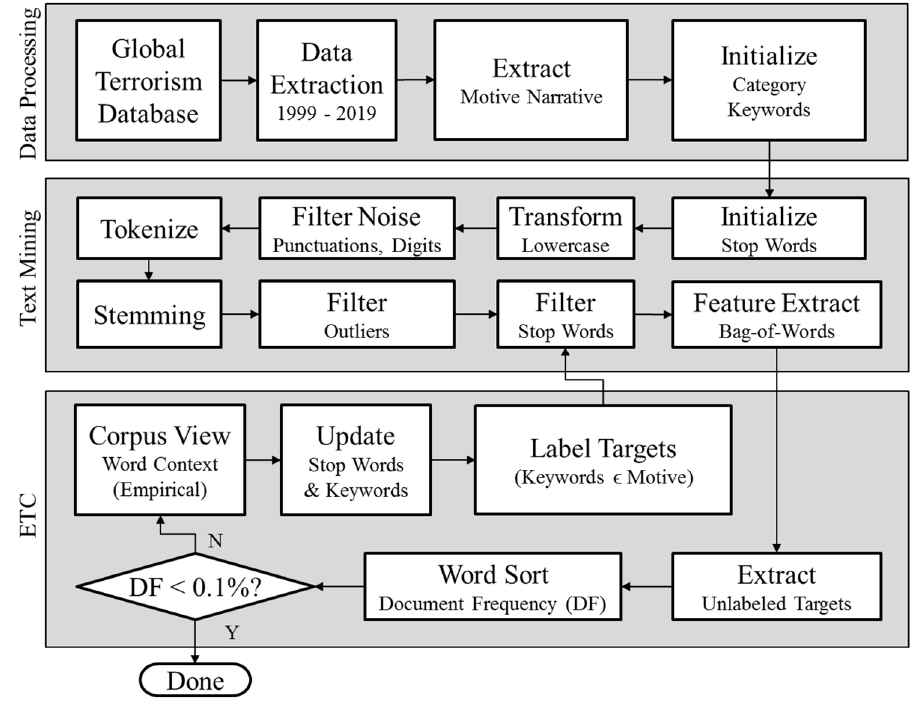
Figure 2. Workflow for empirical topic classification.